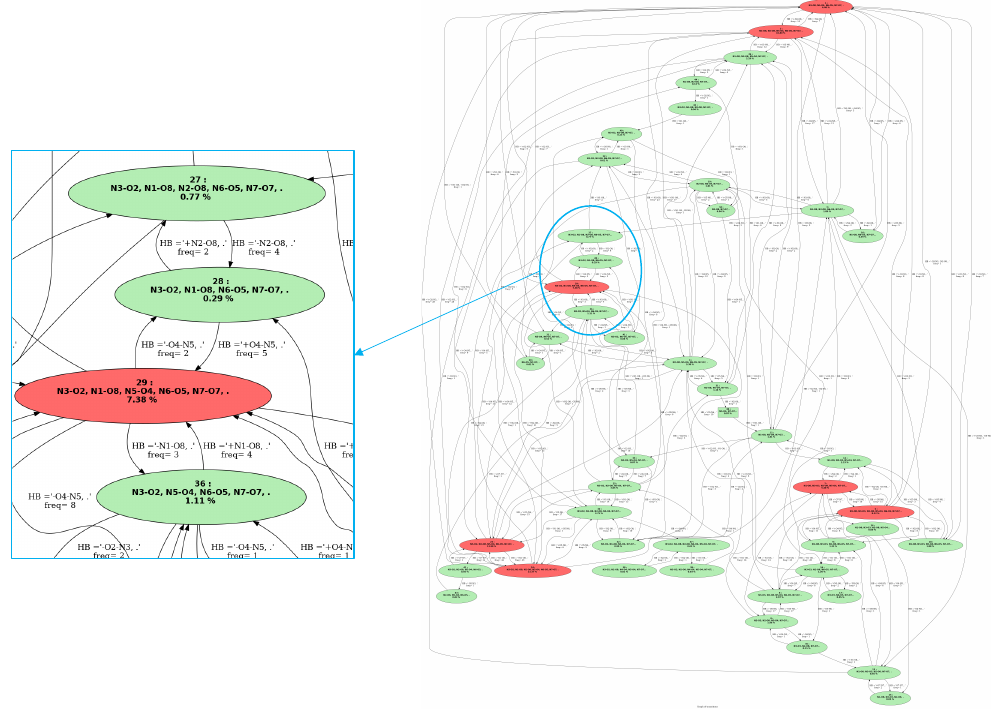
Figure 5. Graph of transitions ( right ) for 150 K dynamics of the gas phase Z − Ala 6 − COOH peptide. The vertices represent the explored conformers. Vertices in red are for conformers with a total percentage of appearance P min % greater than 4%, vertices in green are for conformers with P min % < 4%. These threshold values can be modified at will. Edges between vertices represent the transitions between two conformers as observed over time.The labels on each edge provide the total percentage of occurrence of the transition and the associated chemical changes that occur. Edges are directed. The left figure is the image zoomed over a portion of the graph of transitions displaying the knowledge on four conformers being explored over time. One conformer appears over 29% of the trajectory (red vertex), and the three other conformers appear for less than the minimum threshold value of time ( P min ) (green vertices). The transitions between these conformations are shown with the black